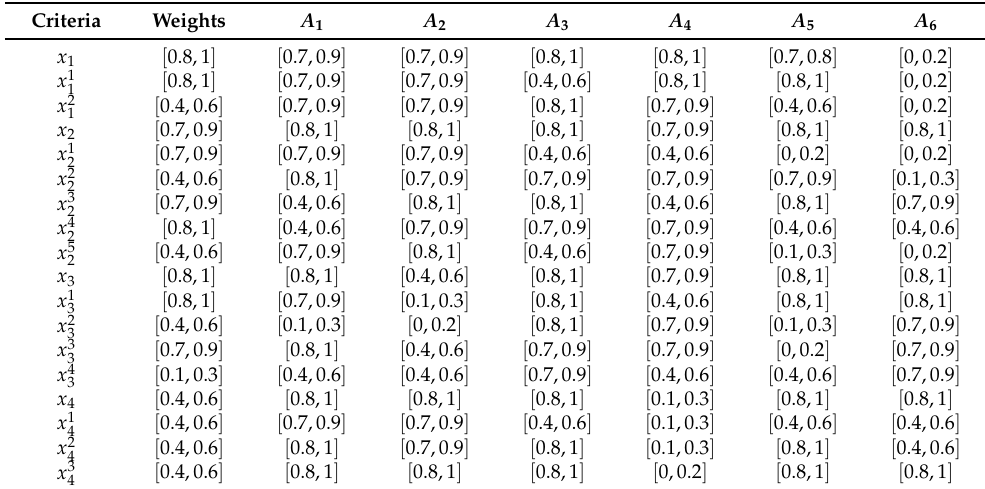
Table 6. The evaluation value of primary criteria for α = 0 with respect to the cabinet frame. Criteria Weights